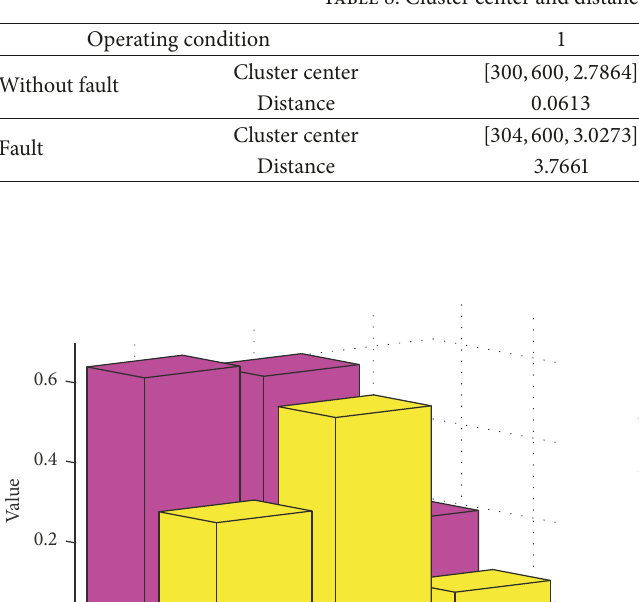
Table 8: Cluster center and distance under normal and fault data.